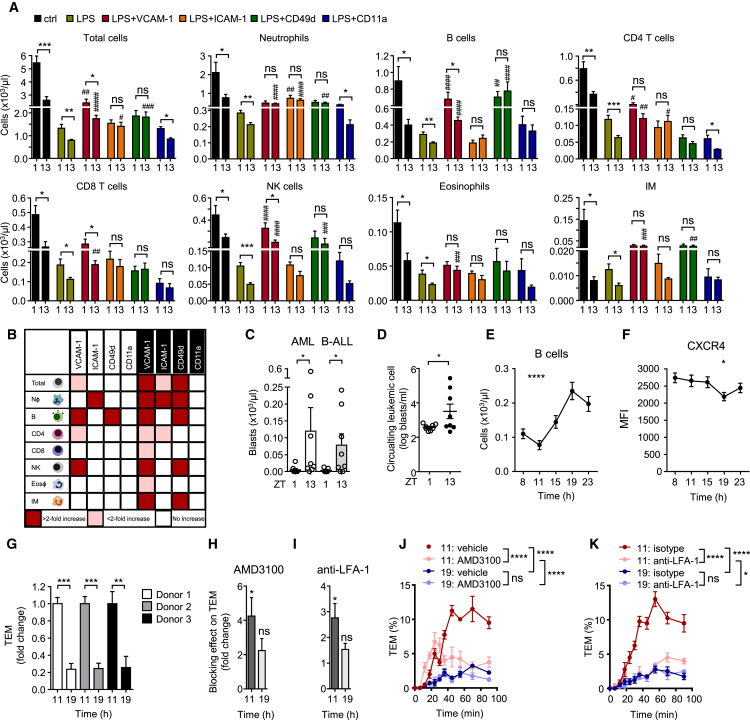
Relevance of Rhythmic Leukocyte Trafficking in Inflammation, Leukemia, and Humans(A) Blood leukocyte numbers after acute treatment without (ctrl) or with LPS in combination with functional blocking antibodies directed against the indicated molecules at ZT1 and ZT13 (n = 3–12 mice; one-way ANOVA followed by Dunnett comparison to the LPS group and unpaired Student’s t test for comparisons between ZT1 and ZT13 groups).(B) Overview of functional blocking effects on leukocyte subsets in blood after LPS treatment targeting the indicated molecules at ZT1 and ZT13 (n = 3–12 mice; one-way ANOVA).(C) Numbers of circulating blasts present in the blood of C57BL/6J CD45.1 recipients at midday 1 week after engraftment at ZT1 and ZT13 with mouse C1498 (AML) or BS50 (B-ALL) cells (n = 7 or 8 mice; Mann-Whitney test).(D) Numbers of circulating blasts present in the blood of NSG recipient mice at midday 1 week after engraftment at ZT1 and ZT13 with human NALM-6 B-ALL cells (n = 8 mice; unpaired Student’s t test).(E) Oscillation of blood B cell numbers in human blood (n = 8 subjects; repeated-measures one-way ANOVA).(F) CXCR4 expression on human B cells over 24 hr (n = 8 subjects; repeated-measures one-way ANOVA).(G) Transendothelial migration (TEM) capacity of human primary B cells harvested from three donors at 11 a.m. and 7 p.m. across HUVECs. Numbers are normalized to 11 a.m. levels (n = 4 assays; unpaired Student’s t test).(H and I) Blocking efficacy of AMD3100 (H) or an anti-LFA-1 antibody (I) on TEM capacity of human primary B cells harvested at 11 a.m. and 7 p.m. Numbers are normalized to and compared with those of vehicle and isotype controls, respectively (n = 3 donors; unpaired Student’s t test).(J and K) Example of the TEM capacity of human B cells from one patient at 11 a.m. and 7 p.m. after AMD3100 (J) or anti-LFA-1 treatment (K) plotted over time (n = 4 assays; two-way ANOVA with Tukey post-test).∗p < 0.05, ∗∗p < 0.01, ∗∗∗p < 0.001, ∗∗∗∗p < 0.0001; #, ##, ###, #### indicate significance levels analogous to those of the LPS groups. All data are represented as mean ± SEM. ns, not significant. See also Figure S7.